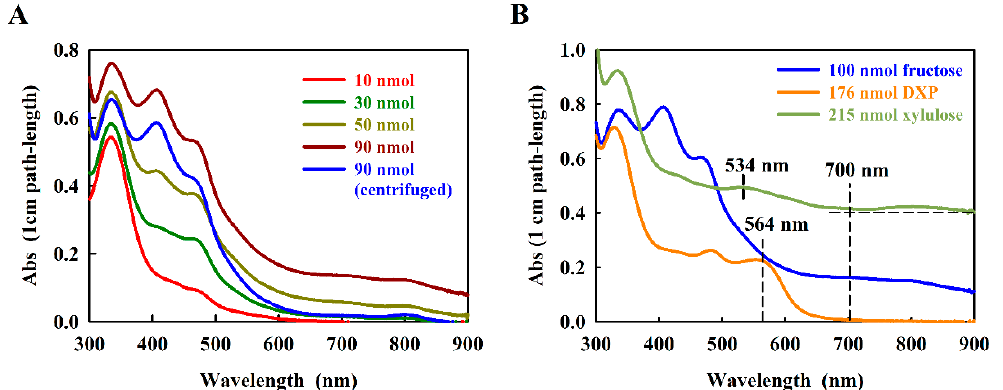
Figure 2. Absorption spectra of the resorcinol adducts with ( A ) D -fructose, and ( B ) D -xylulose and DXP. Concentrations of sugar are indicated. The relevant measurement wavelengths are indicated with dashed vertical lines. The horizontal dashed line shows the baseline value used to calculate the D -xylulose baseline-corrected spectra.